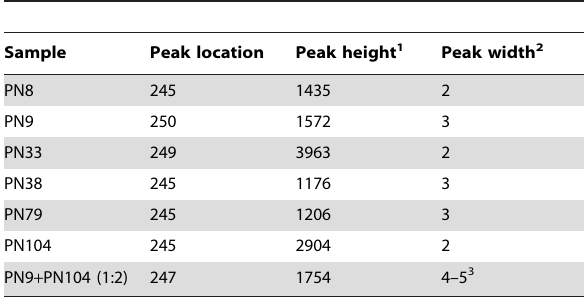
Table 3. Length variability (polymorphism) within the MR2